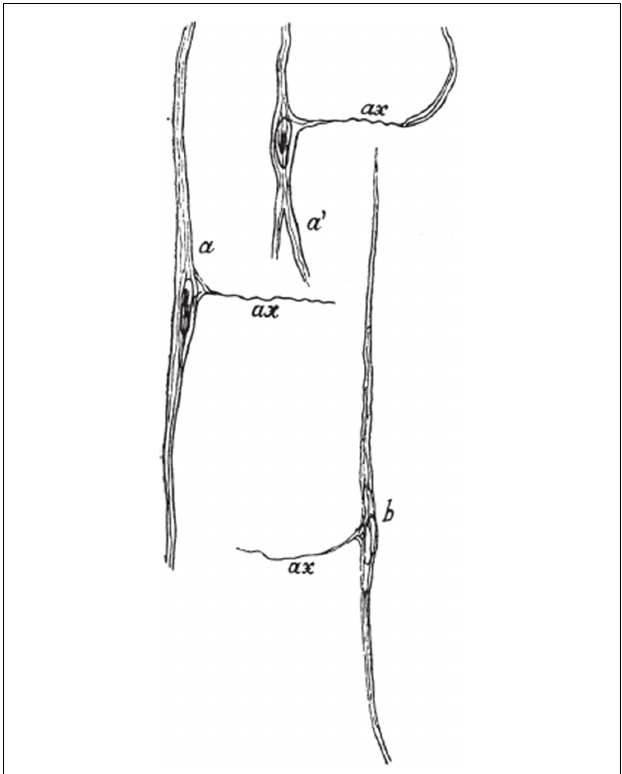
FIGURE 8 | Drawing showing VENs as seen on Bielschowsky silver staining. Note the peculiar depiction of the axon arising laterally from the cell body, differing from all other studies that demonstrated the axon origin of VENs. Image acquired from von Economo